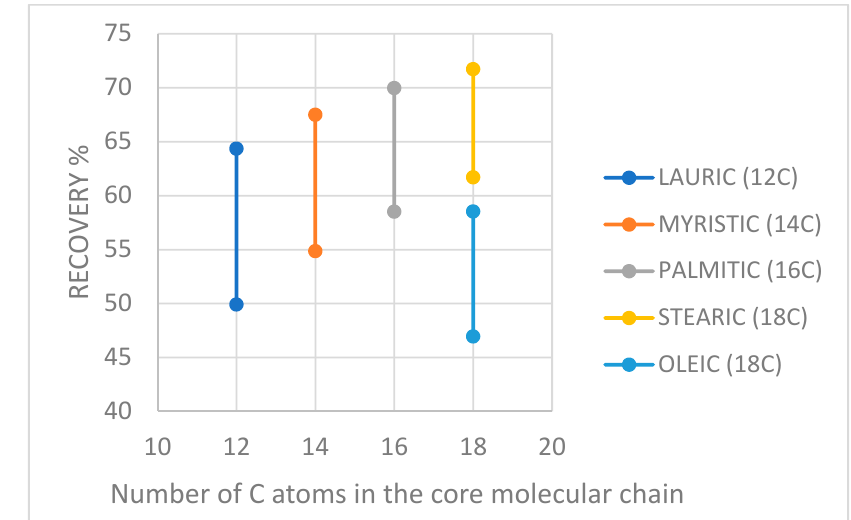
Figure 7. Influence of the free fatty acid chain length on ethanol recovery.